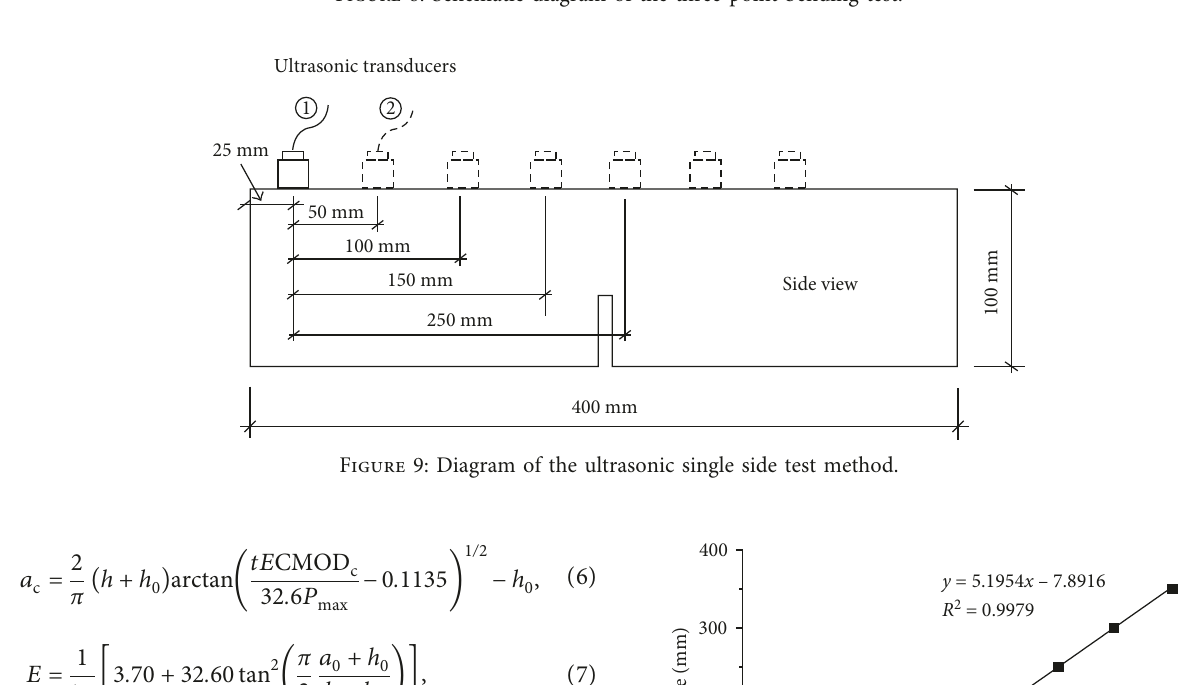
Figure 8: Schematic diagram of the three-point bending test.